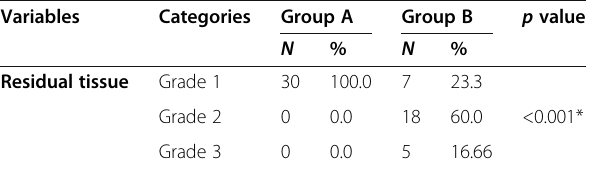
Table 2 Comparison of residual adenoid tissue between two groups Variables